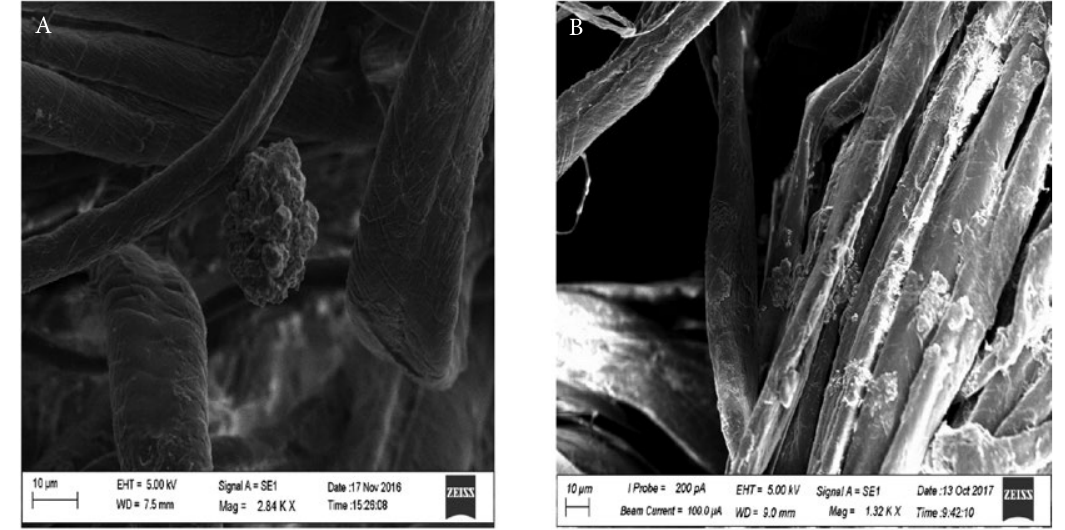
Figure 9. A – SEM images of lime oil microcapsule incorporated textile after washing at 500 rpm (× 2.84 K magnification) B – SEM images of lime oil microcapsules incorporated textile after washing at 500 rpm (× 1.32 K magnification) Table 4. Antibacterial assay results for the lime oil microcapsule incorporated cotton fabric Bacterial